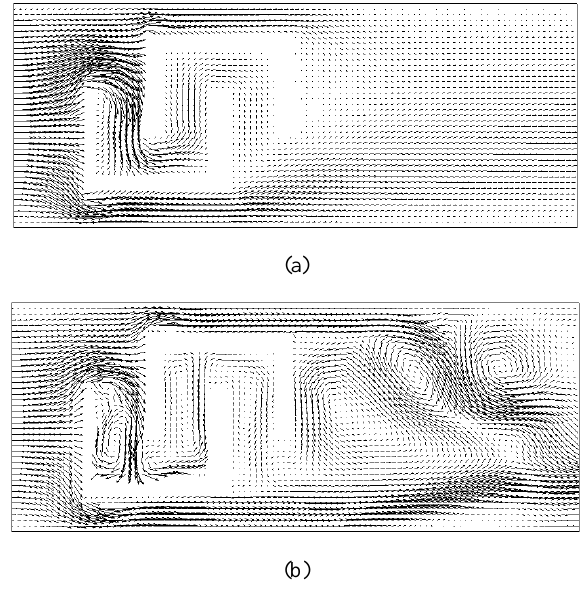
Fig. 7. Flow around the body of complex shape, Re = 30 (a) and Re = 400